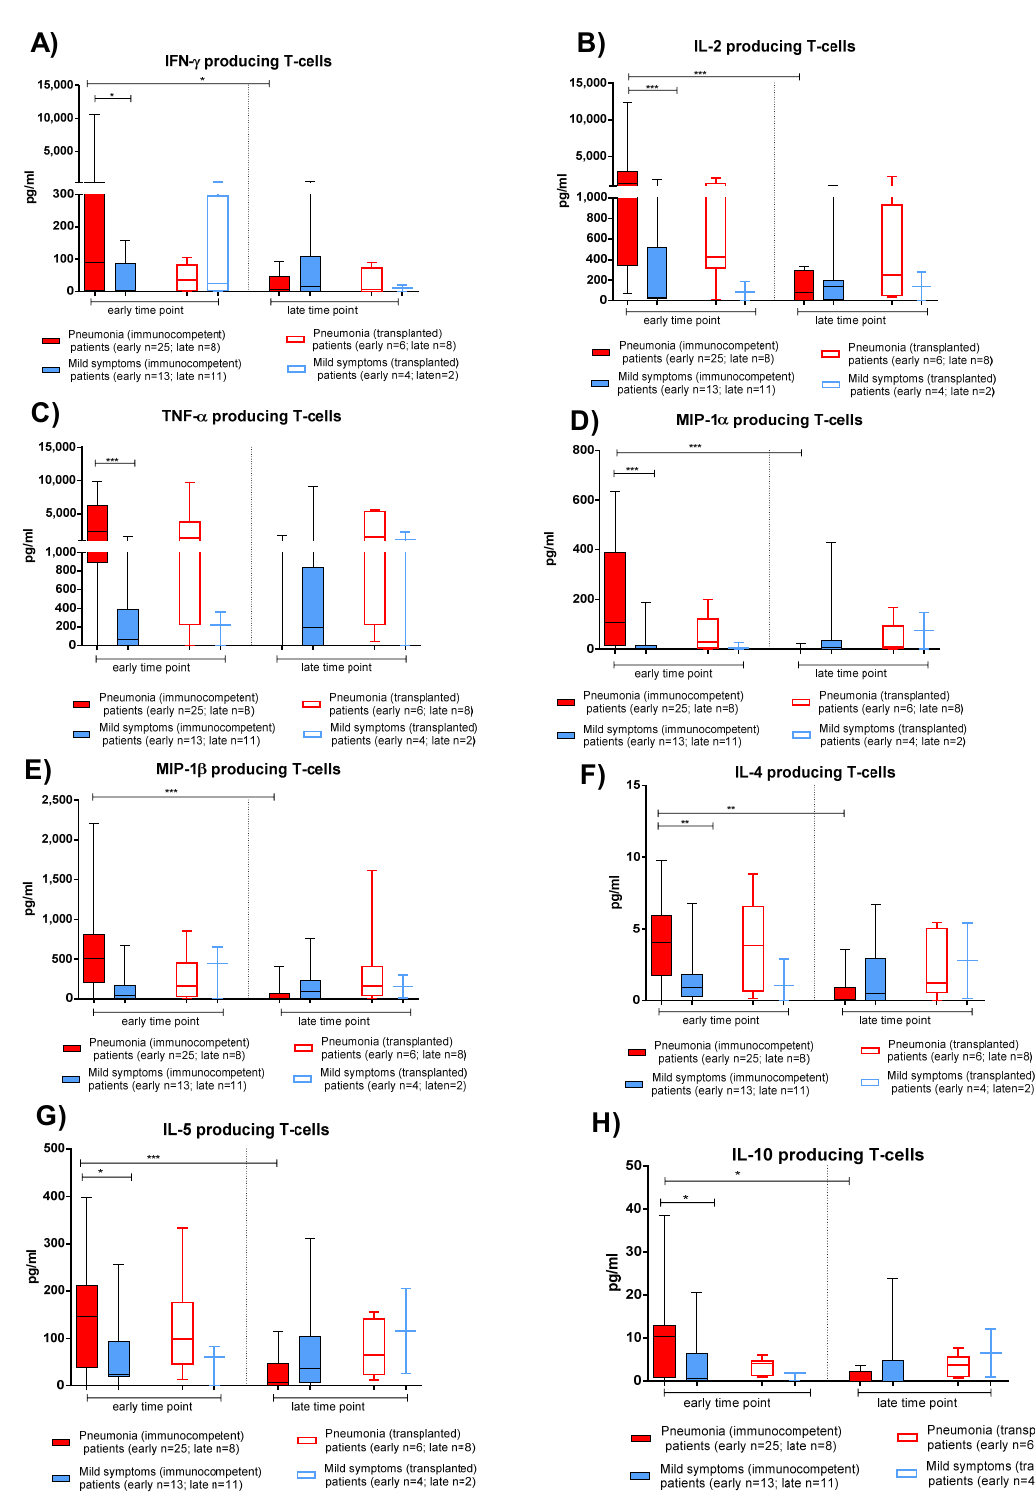
Figure 4. Cytokine production of T-cells after stimulation with Spike (S) peptide pools in immunocompetent and transplanted patients with pneumonia or mild symptoms at early and late time points. ( A ) IFN- γ . ( B ) IL-2. ( C ) TNF- α . ( D ) MIP-1 α . ( E ) MIP-1 β . ( F ) IL-4. ( G ) IL-5. ( H ) IL-10. Early time point: patients with pneumonia, median 59 (range 30–100) days after infection; patients with mild symptoms, 52 (26–100) days after infection. Late time point: patients with pneumonia, median 220 (range 164–400); days after infection; patients with mild symptoms, 189 (150–306) days after infection. * p < 0.05; ** p < 0.01; *** p <